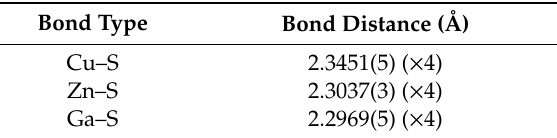
Table 6. Me –S bond distances for